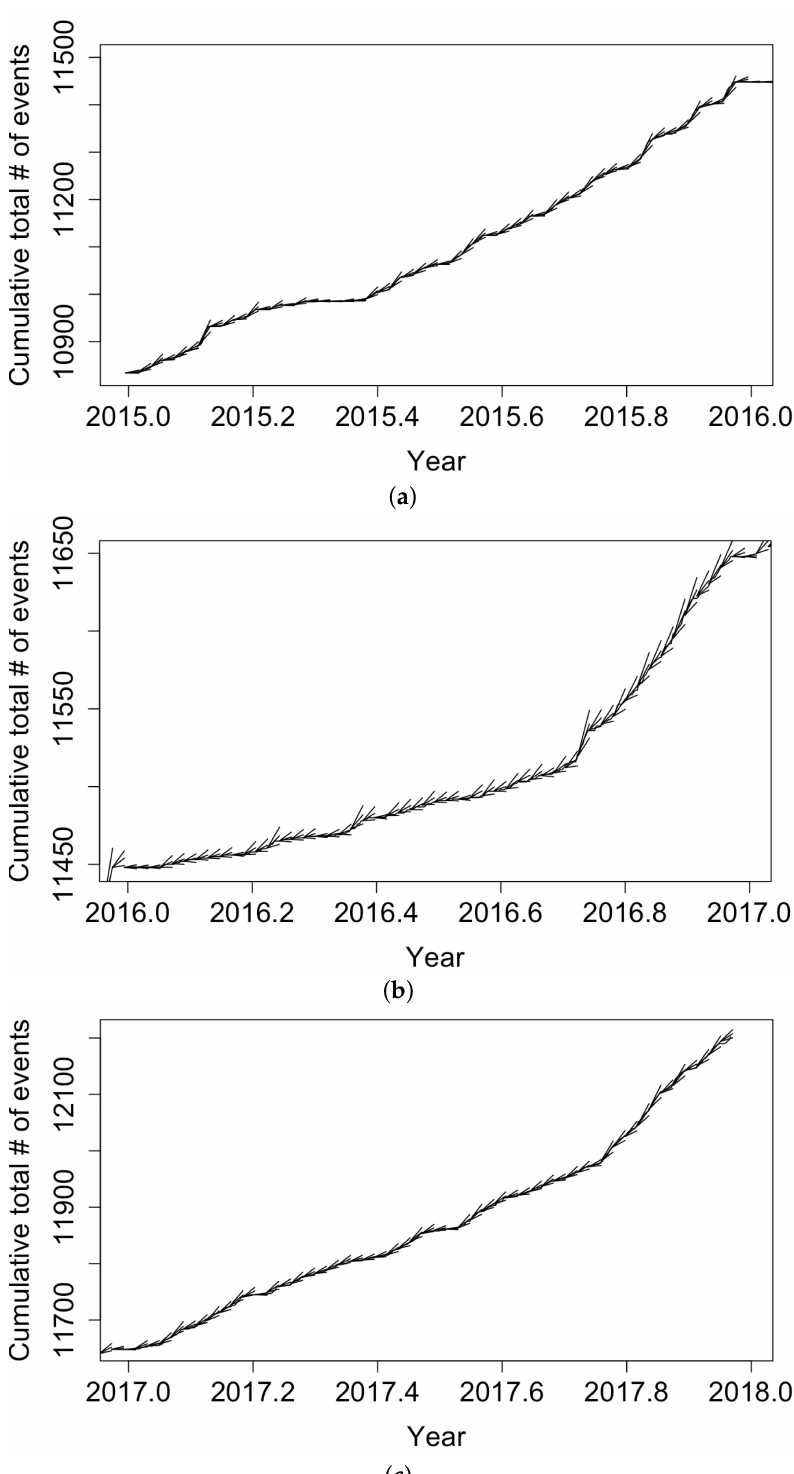
Figure 7. Forecasts of the weekly total number of coccidioidomycosis cases in California using the fitted recursive model and approximate 95% confidence bands, along with reported weekly totals, for ( a ) 2015, ( b ) 2016, and ( c ) 2017. For each week, simulation-based upper and lower 95% confidence bands for the coccidioidomycosis case totals are shown via the whiskers, while the solid black curve shows the observed case count